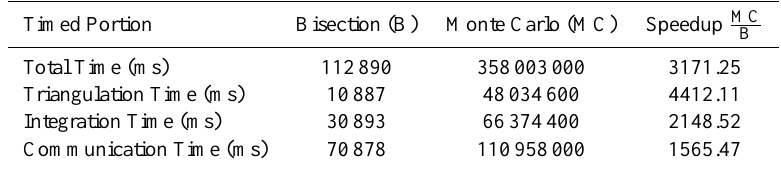
Table 3. Timing results for MPI-SCVT with bisection and Monte Carlo initial generator placements and the speedup of bisection relative to Monte Carlo. Final mesh is fine resolution.